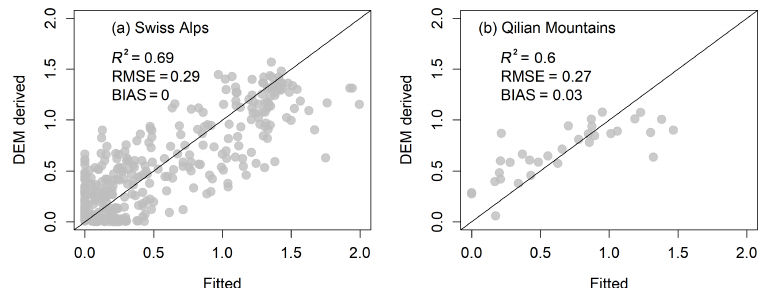
Figure 8. A 10-fold cross validation of DEM-derived LSCF against fitted values in the Swiss Alps (a) and the Qilian Mountains (b) .